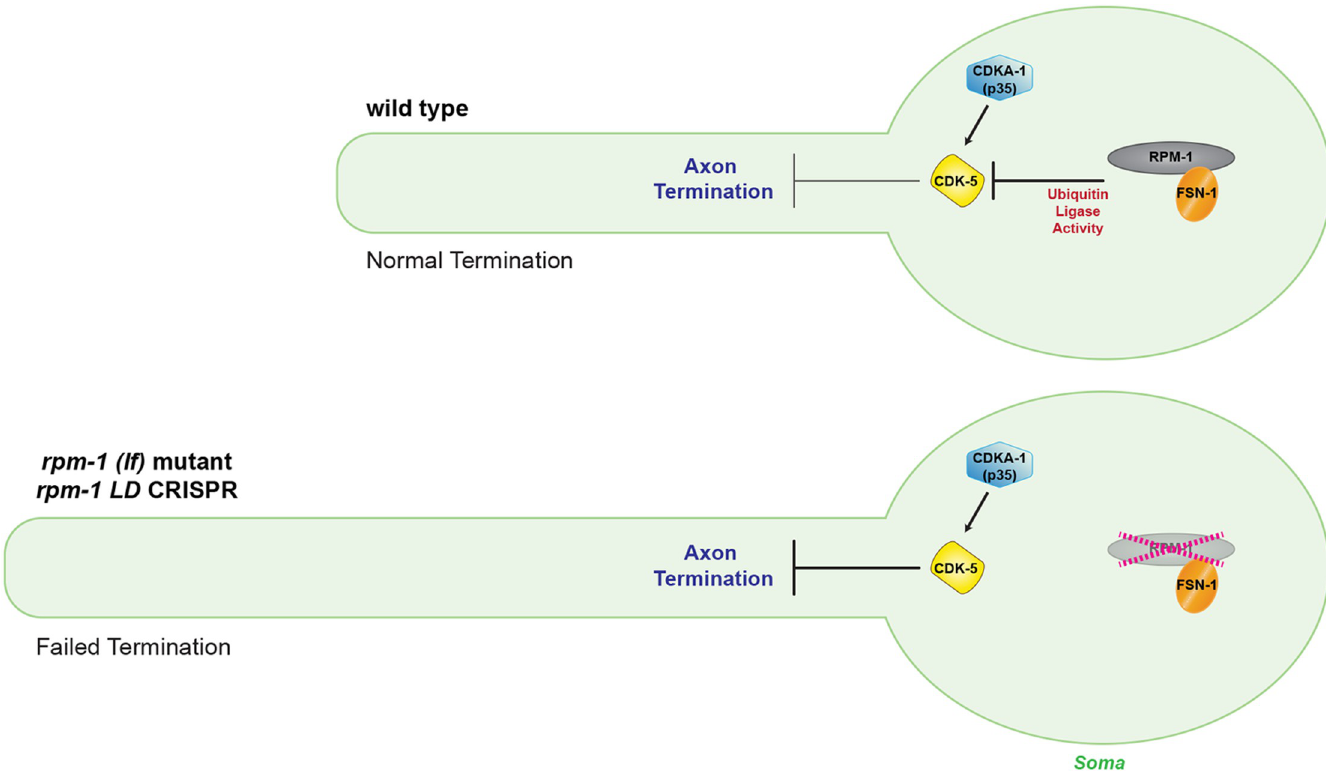
Fig 8. RPM-1/FSN-1 ubiquitin ligase complex inhibits CDK-5 to control axon termination. Summary showing CDK-5 is restricted by RPM-1/FSN-1 ubiquitin ligase activity in the neuronal soma. In wild-type animals (upper diagram), the RPM-1/FSN-1 ubiquitin ligase complex inhibits CDK-5 to facilitate axon termination. In rpm-1 (lf) mutants and rpm-1 LD CRISPR animals (lower diagram), the activity of the RPM-1/FSN-1 ubiquitin ligase complex is impaired and CDK-5 is not restrained. As a result, excess CDK-5 kinase activity impairs axon termination resulting in excess axon growth. CDKA-1(p35) is a known CDK-5 activator.